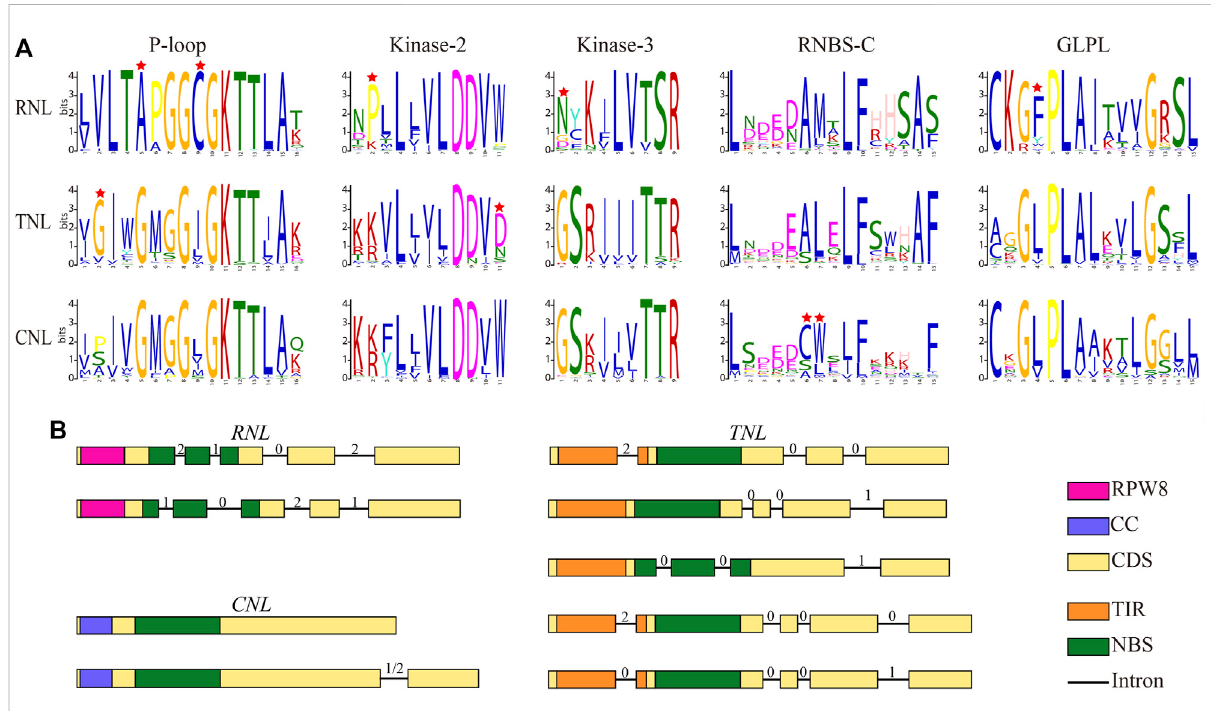
FIGURE 2 Conserved motifs and exon – intron structure models for the three NBS-LRR gene subclasses in Rosaceae genomes. (A) Amino acids of fi ve conserved motifs. Conserved amino acids among CNL , TNL , and RNL subclass genes are labeled with a red star. (B) Exon-intron structure. Filled boxes represent exons and lines represent introns. The numbers on top represent the intron